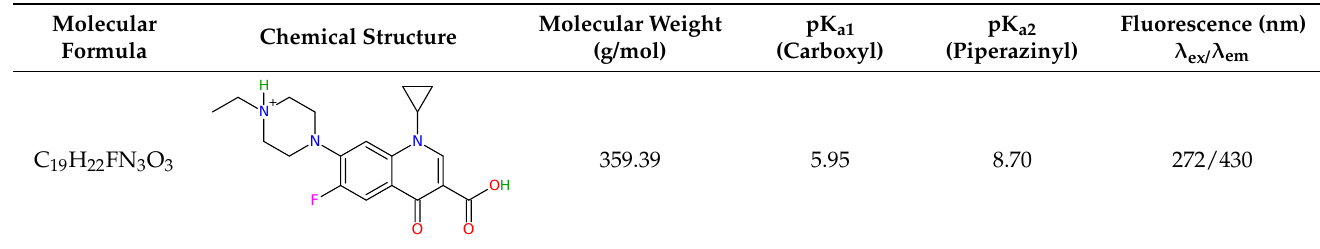
Table 6. Some physicochemical properties of the enrofloxacin molecule.